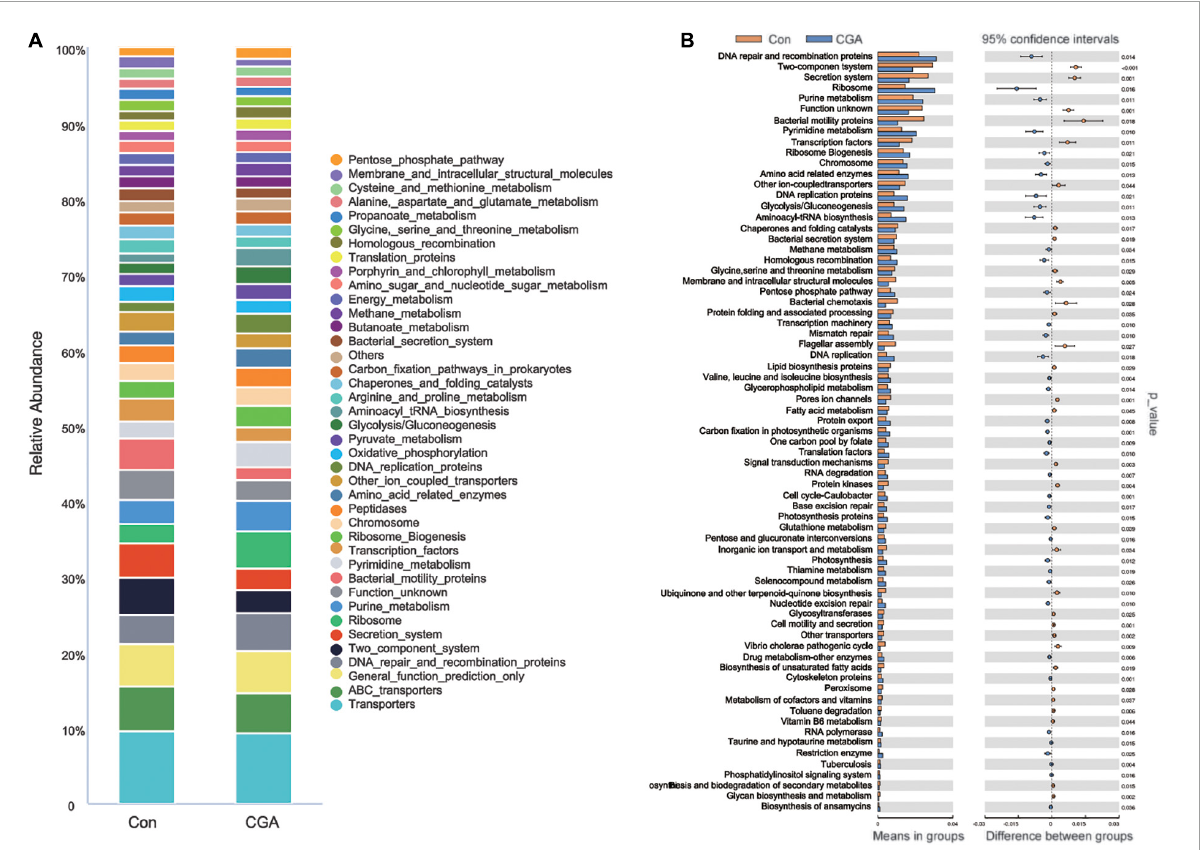
FIGURE7 Kyoto Encyclopedia of Genes and Genomes (KEGG) pathways analysis by Phylogenetic Investigation of Communities by Reconstruction of Unobserved States (PICRUSt). (A) Relative abundance of KEGG pathways for two groups. (B) KEGG pathways with significant differences between two groups ( T -test). The acronym for the chlorogenic acid (CGA)-added group is CGA and the acronym for the control group is